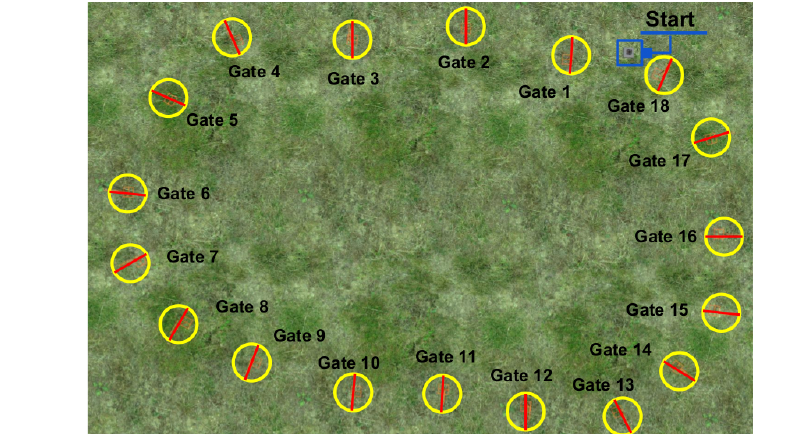
Figure 19. First racetrack to evaluate the mosaic with a total of 18 gates. The track spans over a surface of 62 m × 44 m, and the space in between gates from 7 m to 9 m. The gates’ height are as follows: 7 gates 2 m in height; 8 gates 2.5 m in height; and 3 gates 3 m in height, randomly positioned. Note that this track was not used for training. A video illustrating the performance of our proposed DeepPilot in this racetrack can be found at